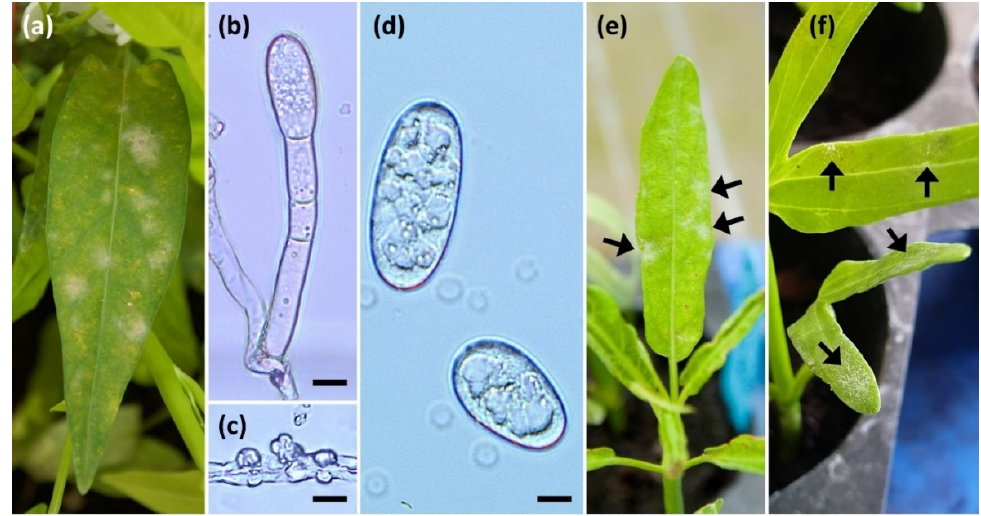
Scale bars in ( a ) = 1 cm, in ( b – e ), and ( g – k ) = 10 μ m. Arrows indicate the colonies of the powdery mildew.